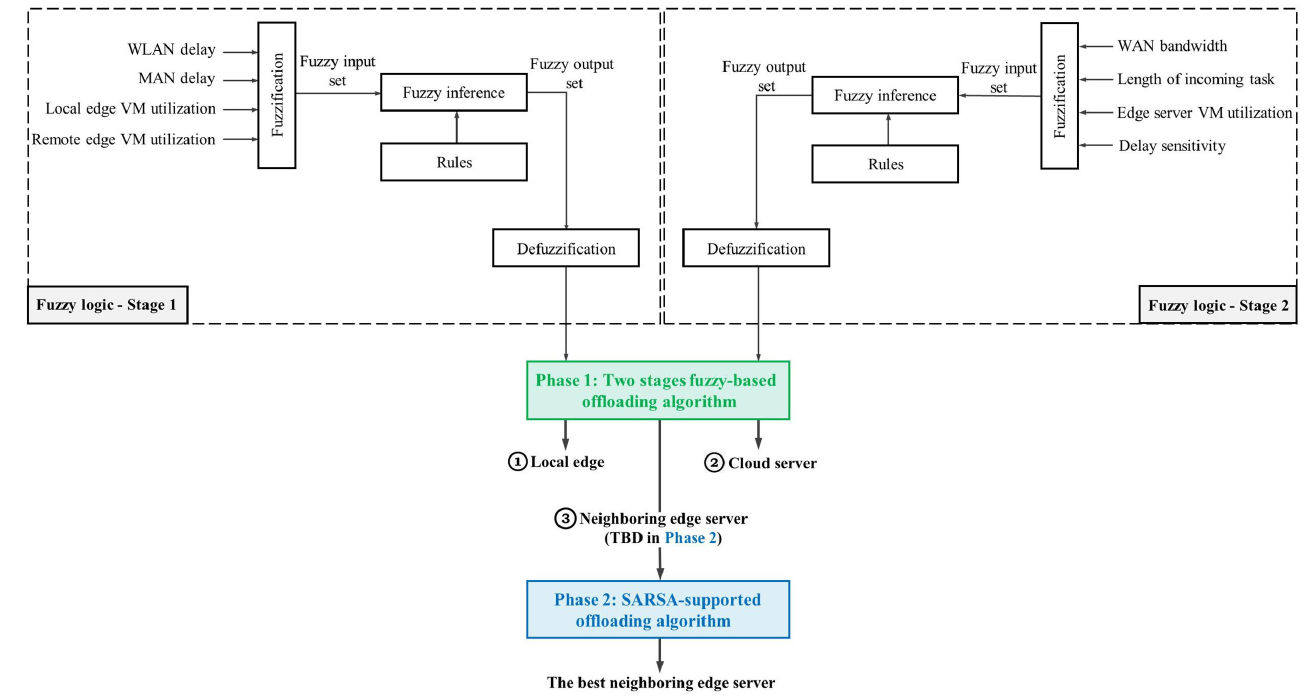
Figure 3. Fu-SARSA algorithm